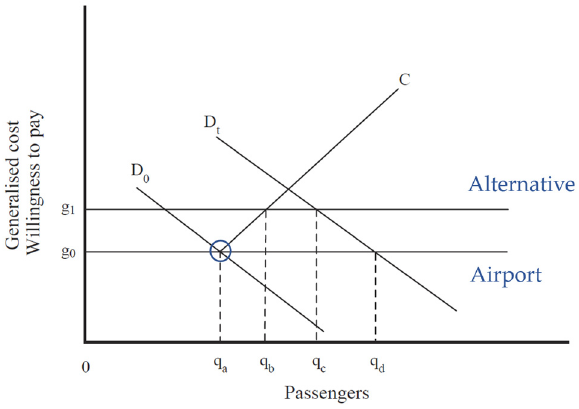
Figure 5. User benefits, derived from [32].